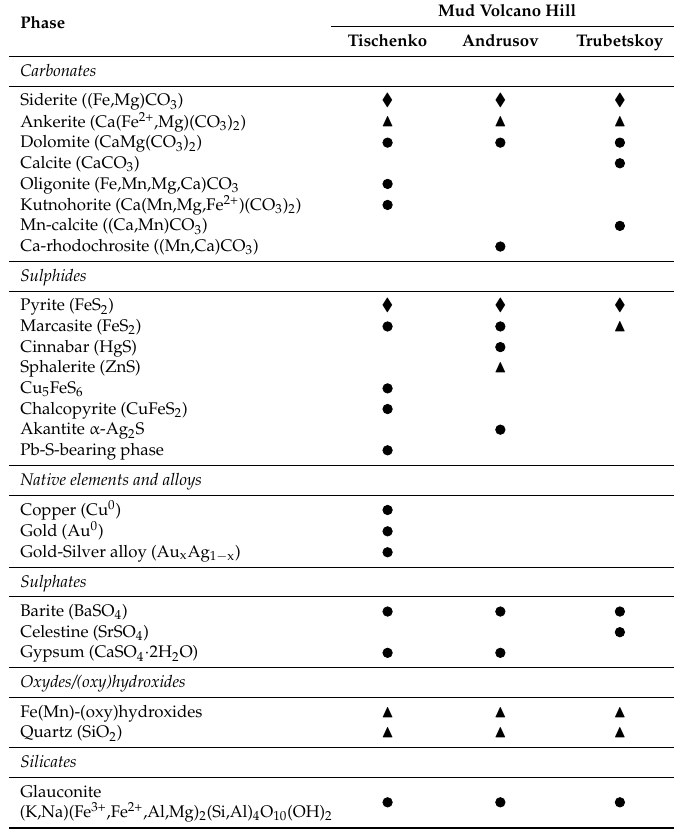
Table 3. Authigenic minerals identified in the heavy fraction of the mud masses from Bulganak MV area (optical microscopy, SEM, XRD and